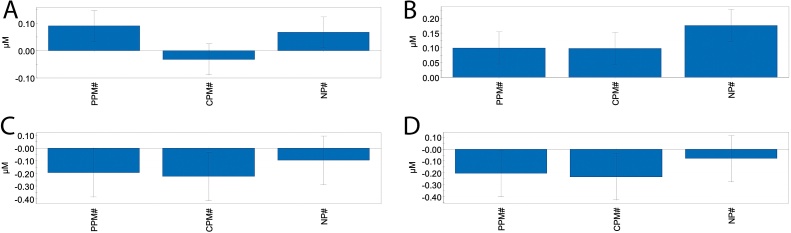
PLS models of four lipid species showing significant contribution in Atlantic salmon hepatocytes after exposure to chlorpyrifos-methyl (CPM), pirimiphos-methyl (PPM) and nonylphenol (NP). Simplified scaled and centered PLS regression coefficients with 95 % confidence intervals based on lipid levels (fractional factorial design). The model contained three PLS components. A) Free FA (22:5), regression: p = 0.0040, R2 = 0.55 and Q2 = 0.38, with significant coefficients for PPM (p = 0.0030) and NP (p = 0.022). B) LPC (18:0), regression: p = 0.0000, R2 = 0.83 and Q2 = 0.69, with significant coefficients for PMM (p = 0.0013), CPM (p = 0.0015), and NP (p = 398-006) C) TAG52:1-FA16:0, regression: p = 0.028, R2 = 0.42 and Q2 = 0.17, with significant coefficients for PPM (p = 0.0475), CPM (p = 0.026), and D) TAG52:1-FA18:0, regression: p = 0.025, R2 = 0.43 and Q2 = 0.19, with significant coefficients for PPM (p = 0.0403), CPM (p = 0.0216).